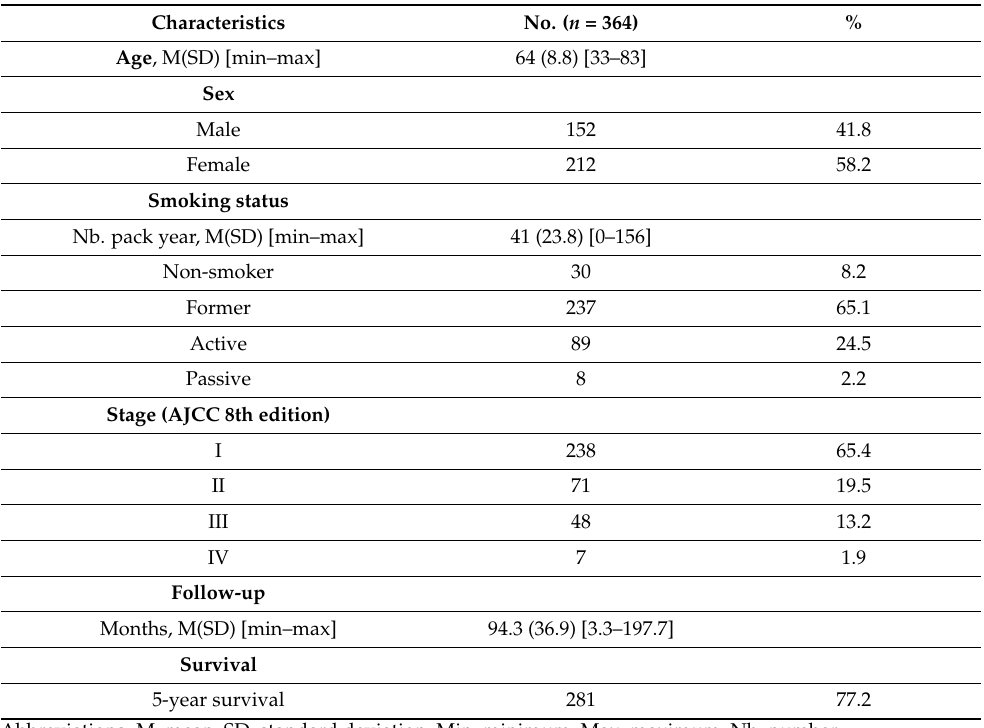
Table 1. Clinical characteristics of the cohort.